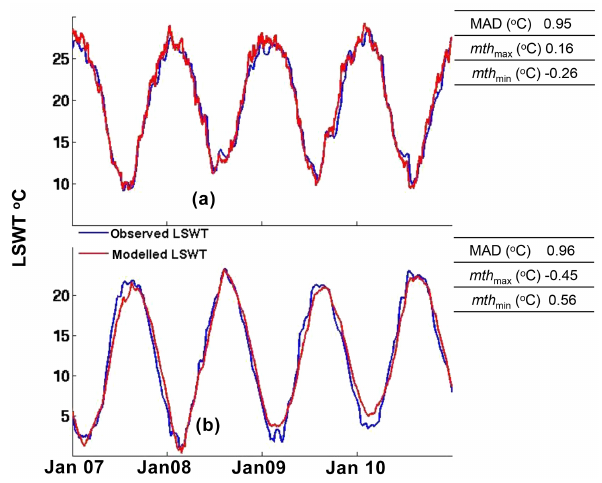
Figure 14. Observed LSWT versus tuned model LSWT for saline and high altitude lakes (a) Lake Chiquita, Argentina (31 ◦ S 63 ◦ W, salinity 145gL − 1 ) ; (b) Lake Van, Turkey (39 ◦ N 43 ◦ E, 1638ma.s.l., salinity 22gL − 1 ) .